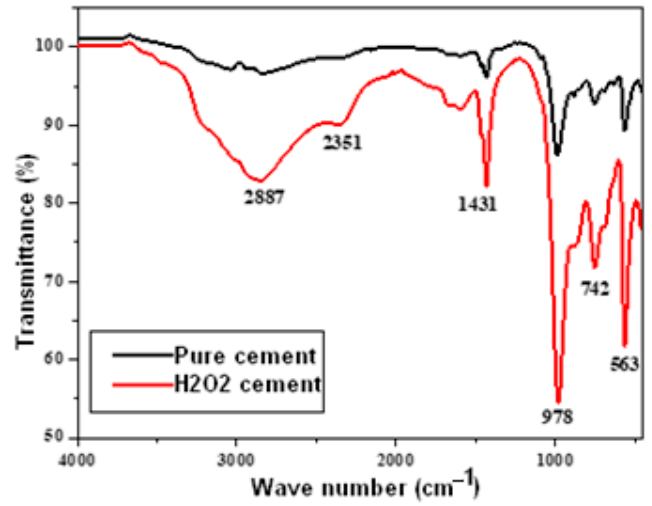
Figure 5. FTIR of pure and H 2 O 2 cements.